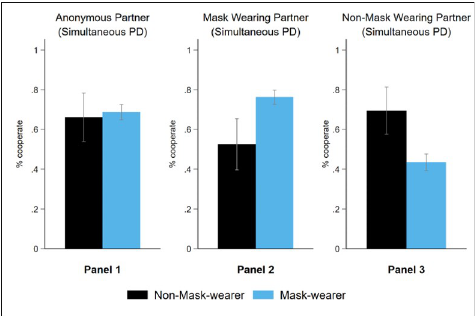
Fig 3. Average cooperation levels in PD games after mask usage elicitation. 4-standard-error bars (2 above, 2 below) to represent 95% confidence intervals.